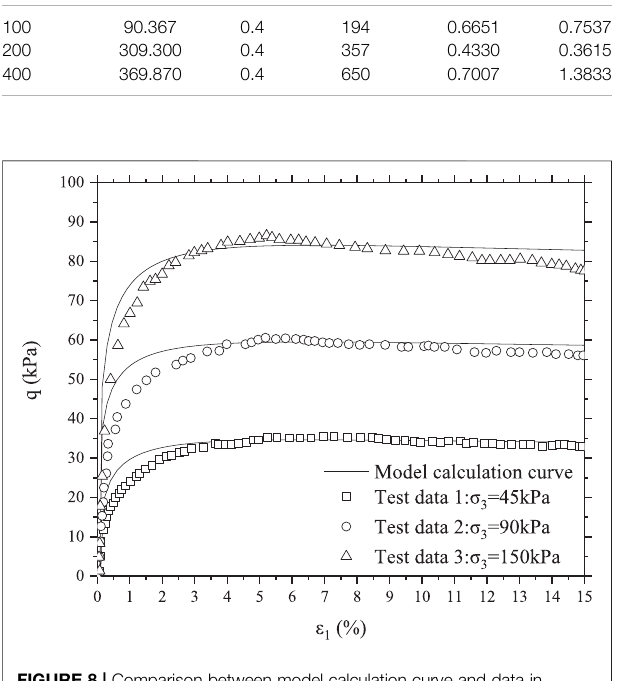
FIGURE 8 | Comparison between model calculation curve and data in reference Meng et al.,